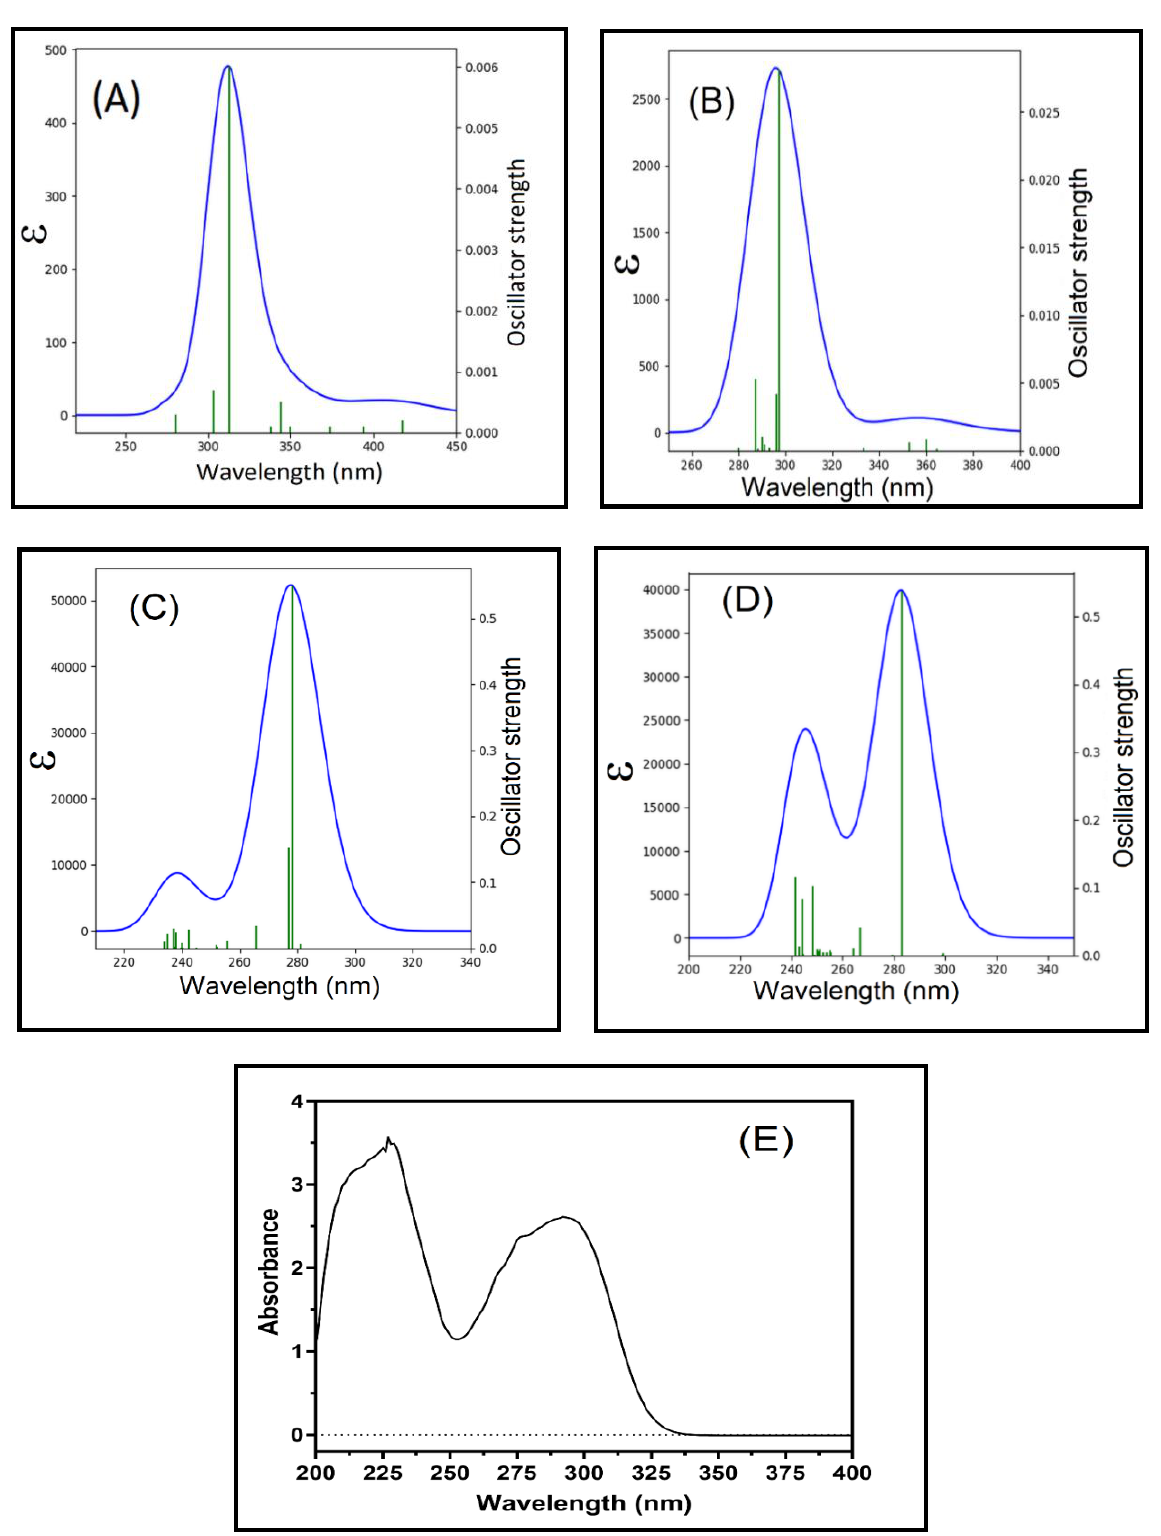
Figure 3. ( A , B, C ) TD-DFT calculated absorption spectra in the gas phase and water solvent for complexes conformation S1 ( A , C ) and S2 ( B , D ), respectively. ( E ) Experimental absorption spectrum of the title complex in water solvents at room temperature.